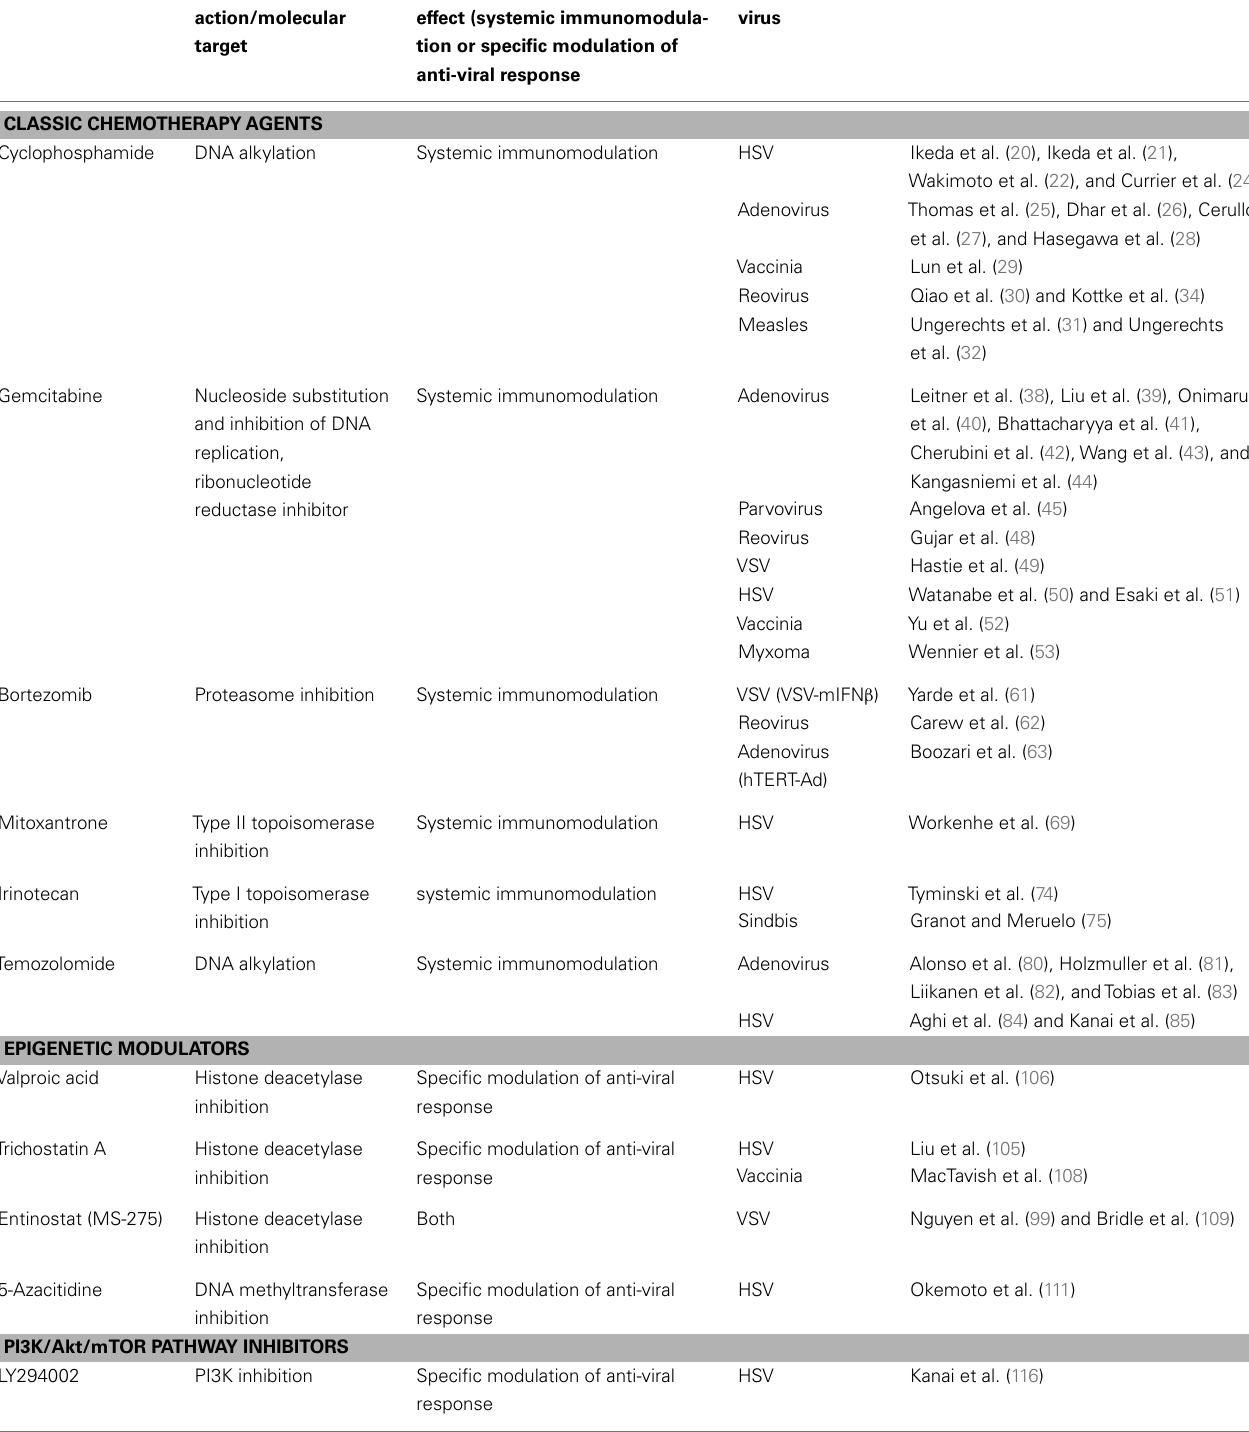
Table 1 | Combinations of pharmacological and oncolytic therapies with demonstrated improvements in in vivo treatment efficacy